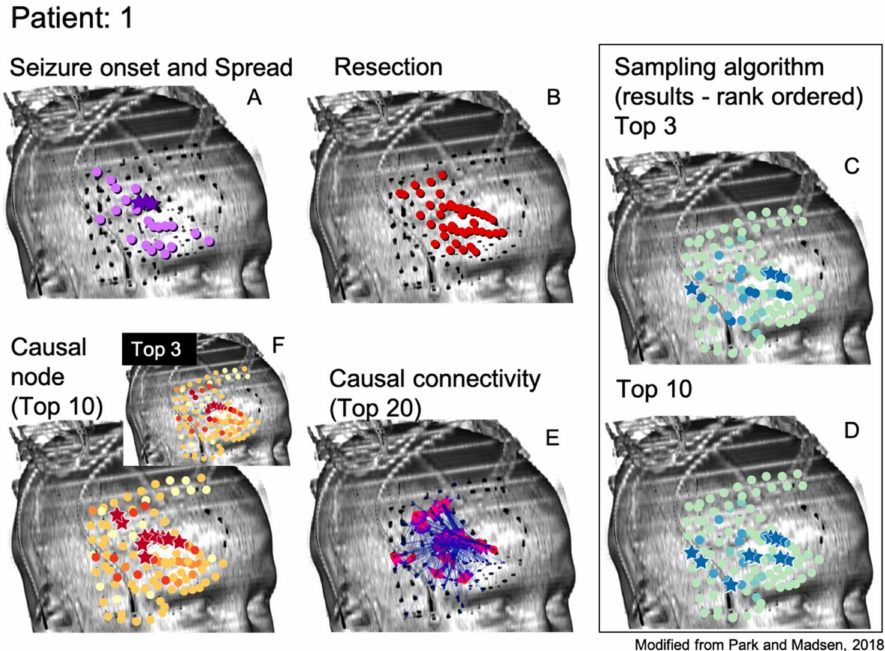
Figure 2. Results for the Monte Carlo sampling algorithm (1000 random restarts, 1000 samples per random restart) run on one patient are shown. Shown are the neurologist-determined SOZ (panel A ) and surgical RZ (panel B ) determined through means currently utilized for epilepsy surgery. The top 3 (panel C ) and top 10 (panel D ) ranked nodes according to the sampling algorithm are displayed. Note the similarities between top sampling nodes and neurologist-determined SOZ and RZ nodes. (Panel E ) shows the most influential edges of the GC map for reference. It is along such edges that tokens travel in the sampling algorithm. (Panel F ) shows the top 3 and 10 nodes as determined by the total GC outdegree method, also for reference [1].